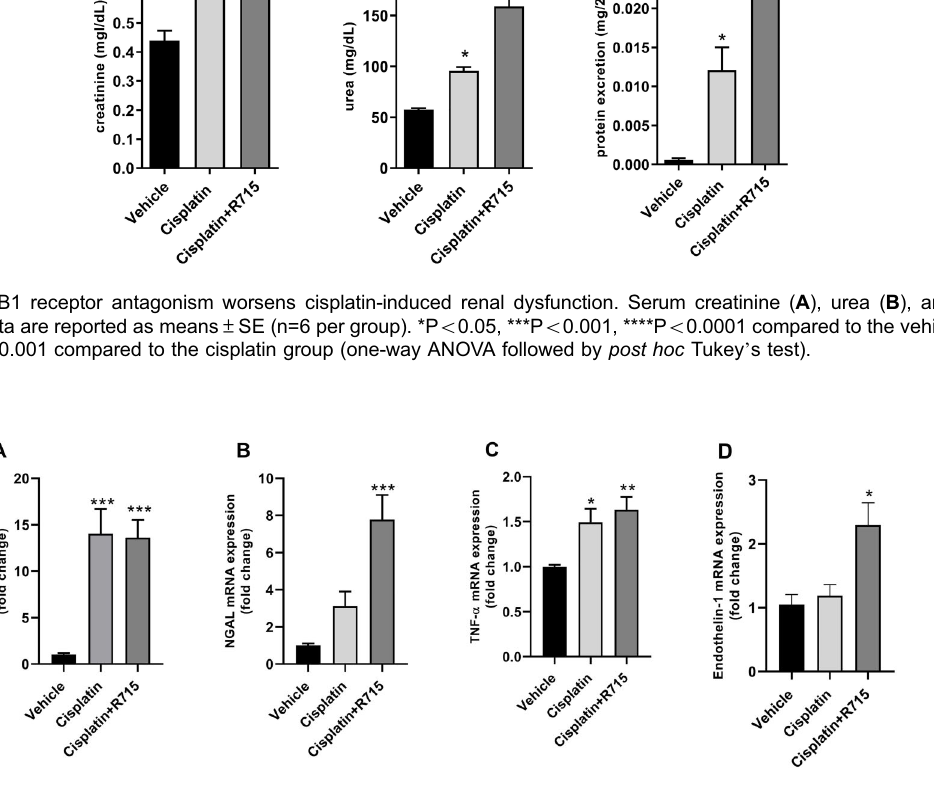
Figure 4. Multiple cisplatin treatment induces kidney damage. Renal mRNA levels of KIM-1 ( A ), NGAL ( B ), TNF- a ( C ), and endothelin-1 ( D ). Data are reported as means ± SE (n=6 per group). *P o 0.05, **P o 0.01, ***P o 0.001 compared to the vehicle group (one-way ANOVA followed by post hoc Tukey ’ s test).